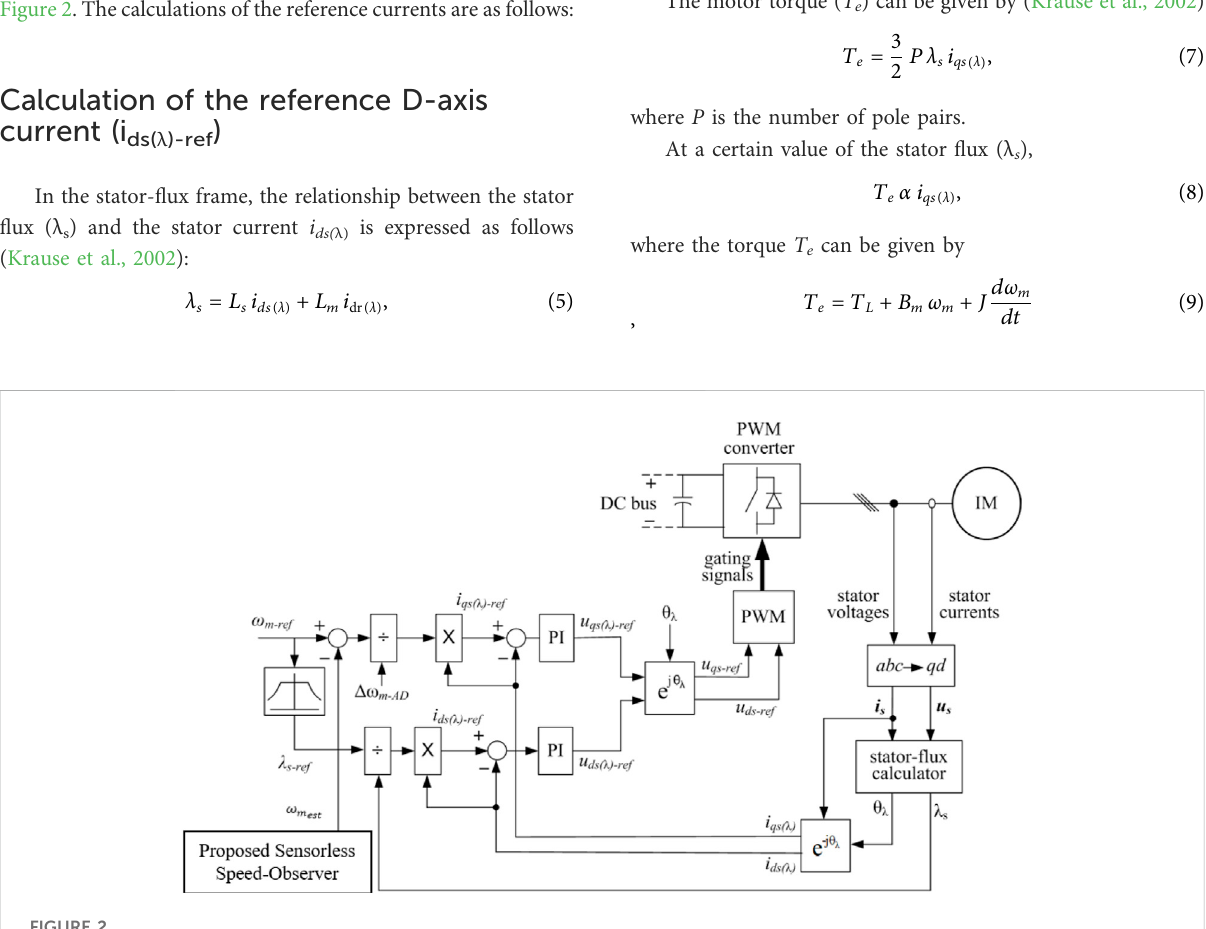
Figure 2. The calculations of the reference currents are as follows: